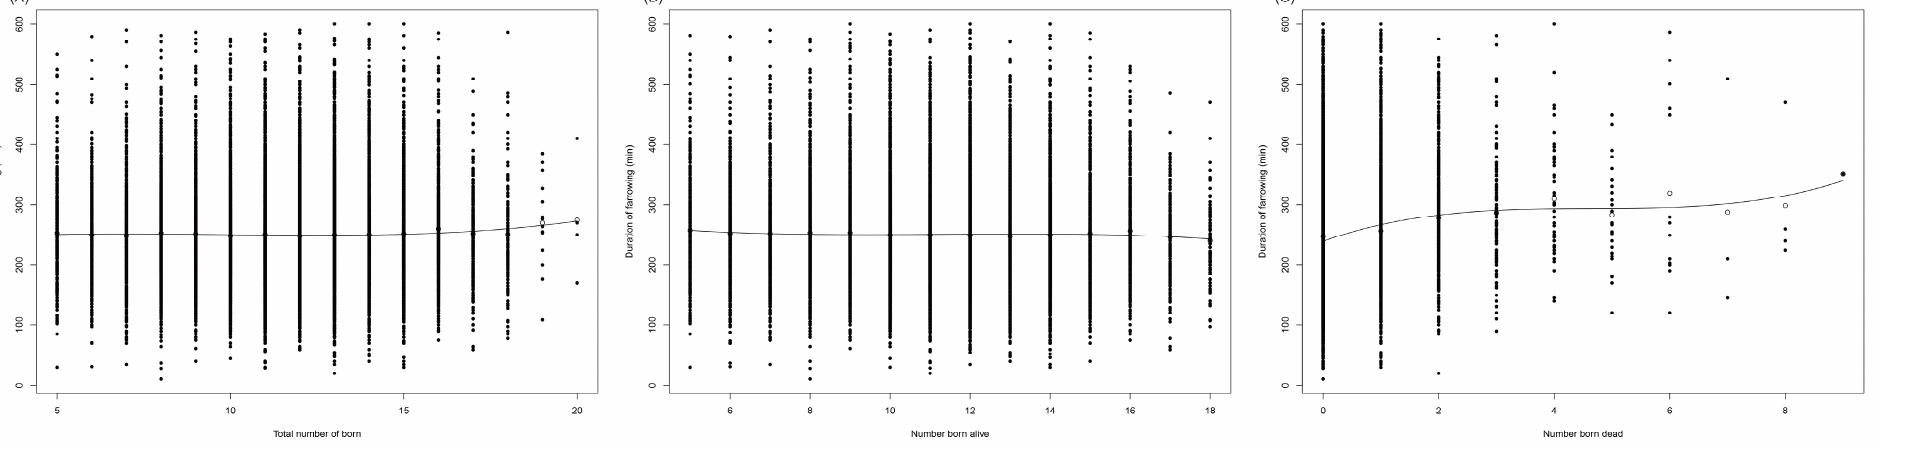
Table 2. Descriptive statistics of farrowing duration of different total number of born and number born alive piglets.